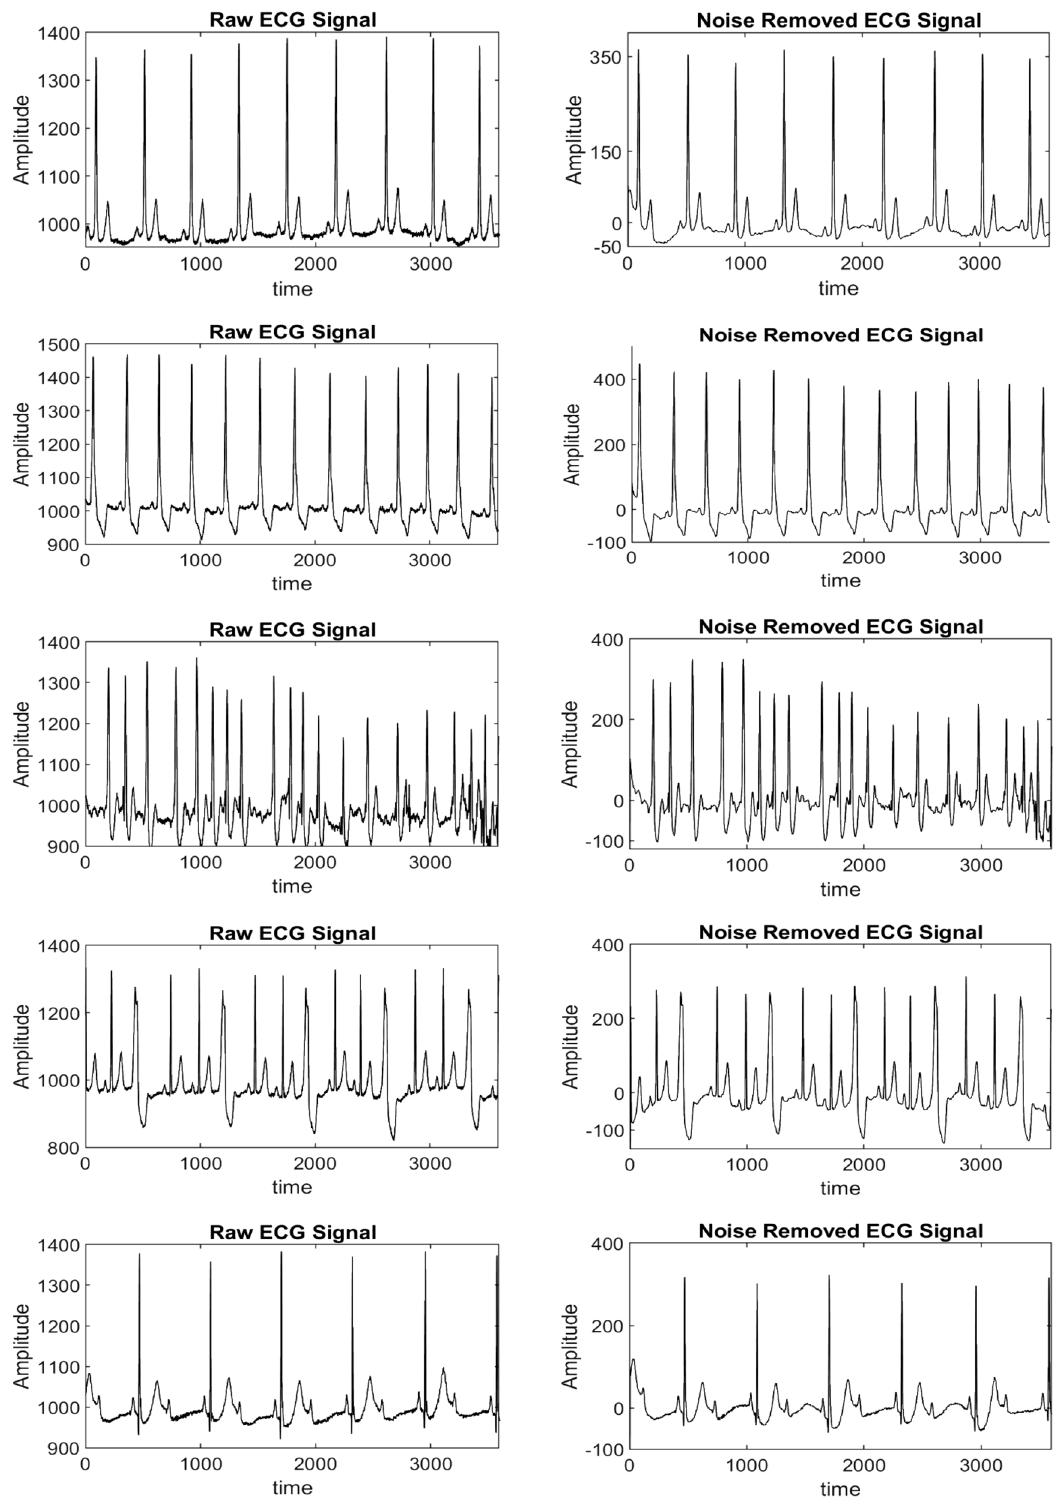
Figure 12. Raw ECG signals and noise removed ECG